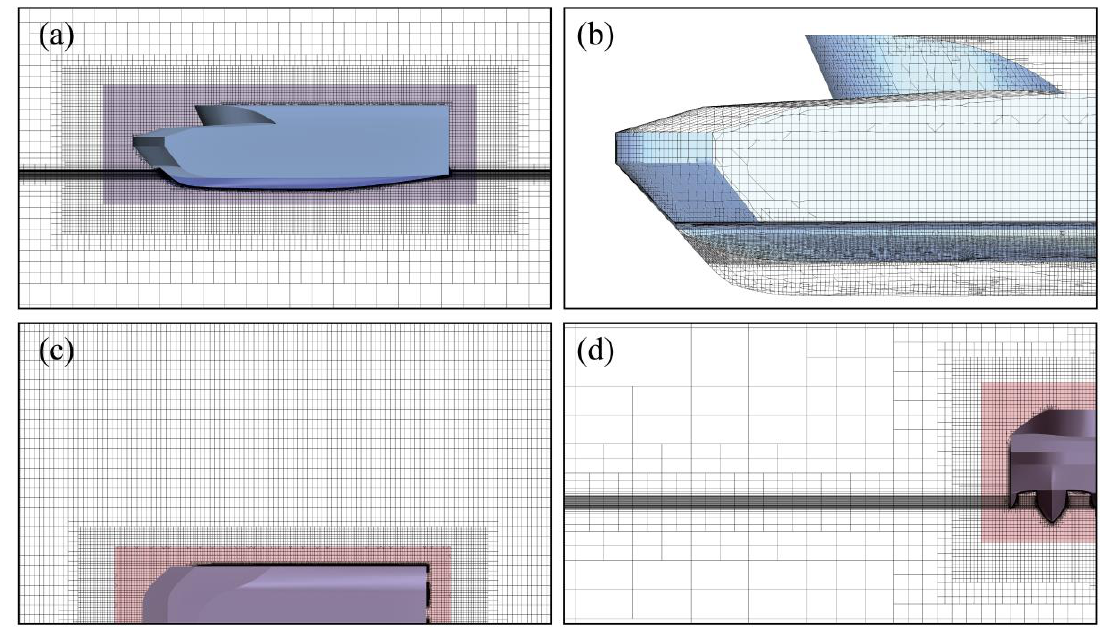
Figure 5. Grid arrangement around the Double-M craft for λ /L = 1.50: ( a ) XZ-plane view, ( b ) Surface mesh view, ( c ) XY-plane view, ( d ) YZ-plane view.